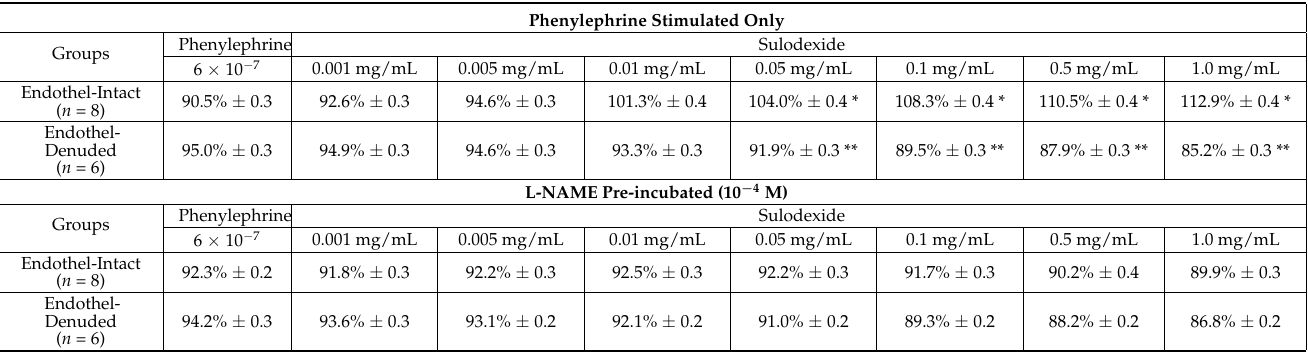
Table 2. The contraction response of phenylephrine-stimulated venous rings exposed to cumulative sulodexide concentrations only, and in the L-NAME-incubated rings in endothelium-intact and denuded samples. * p < 0.05 within-group comparison ** p < 0.05 between-groups comparison. Phenylephrine Stimulated